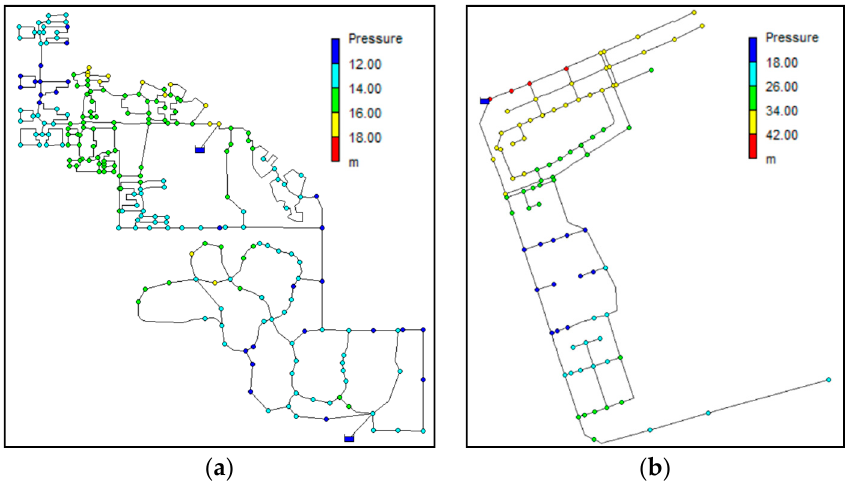
Figure 7. Pressure distributions of ( a ) Network 1 and ( b ) Network 2.